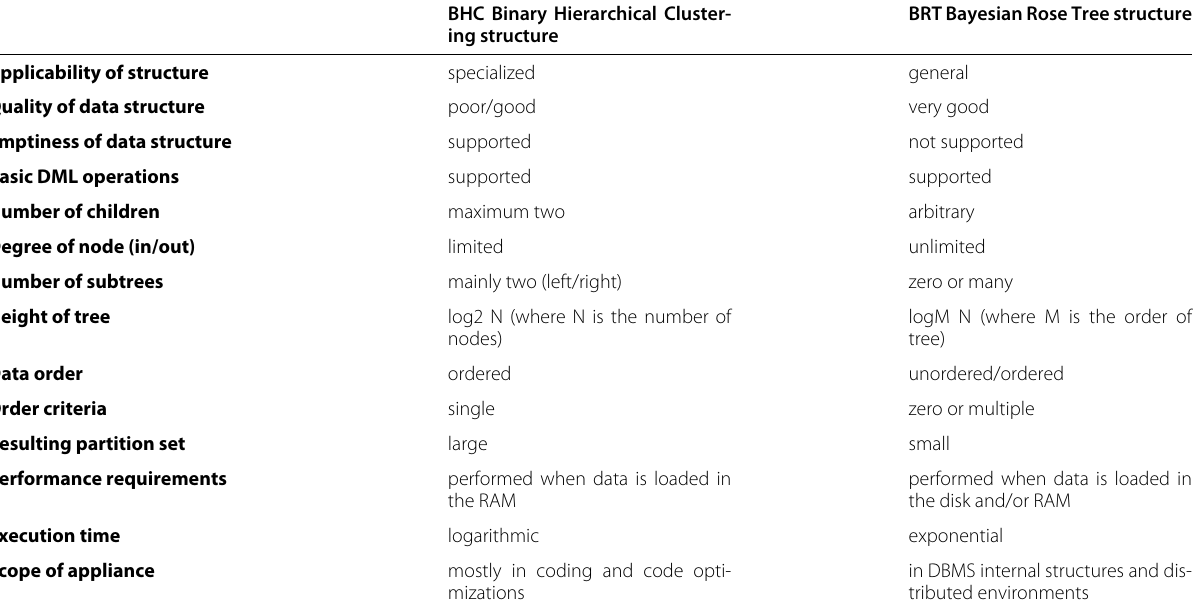
Table 1 Main differences between BHC Binary Hierarchical Clustering and BRT Bayesian Rose tree structural data